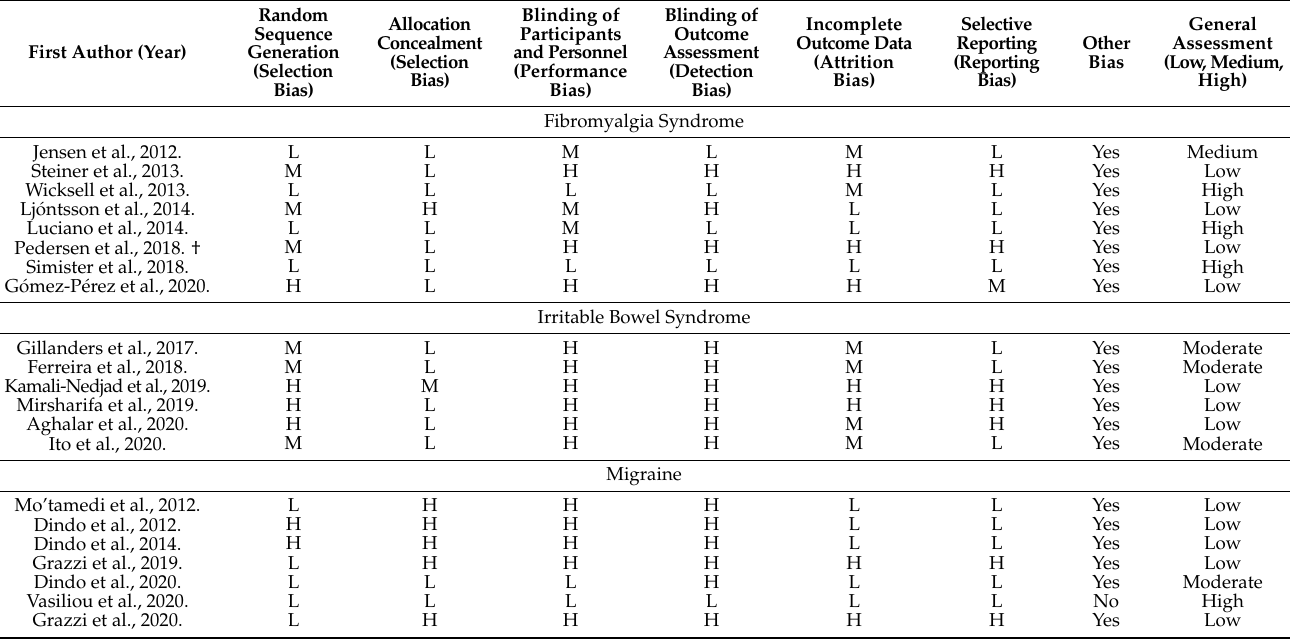
Table 2. Risk of Bias Assessment of relevant eligible